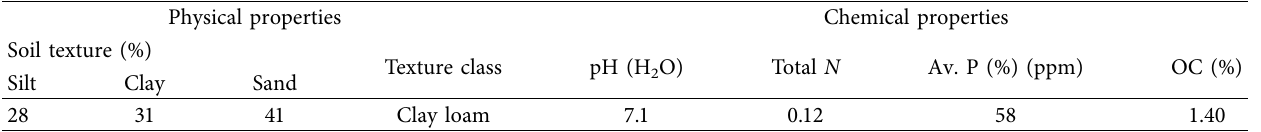
Table 2: Physical and some chemical characteristics of experimental